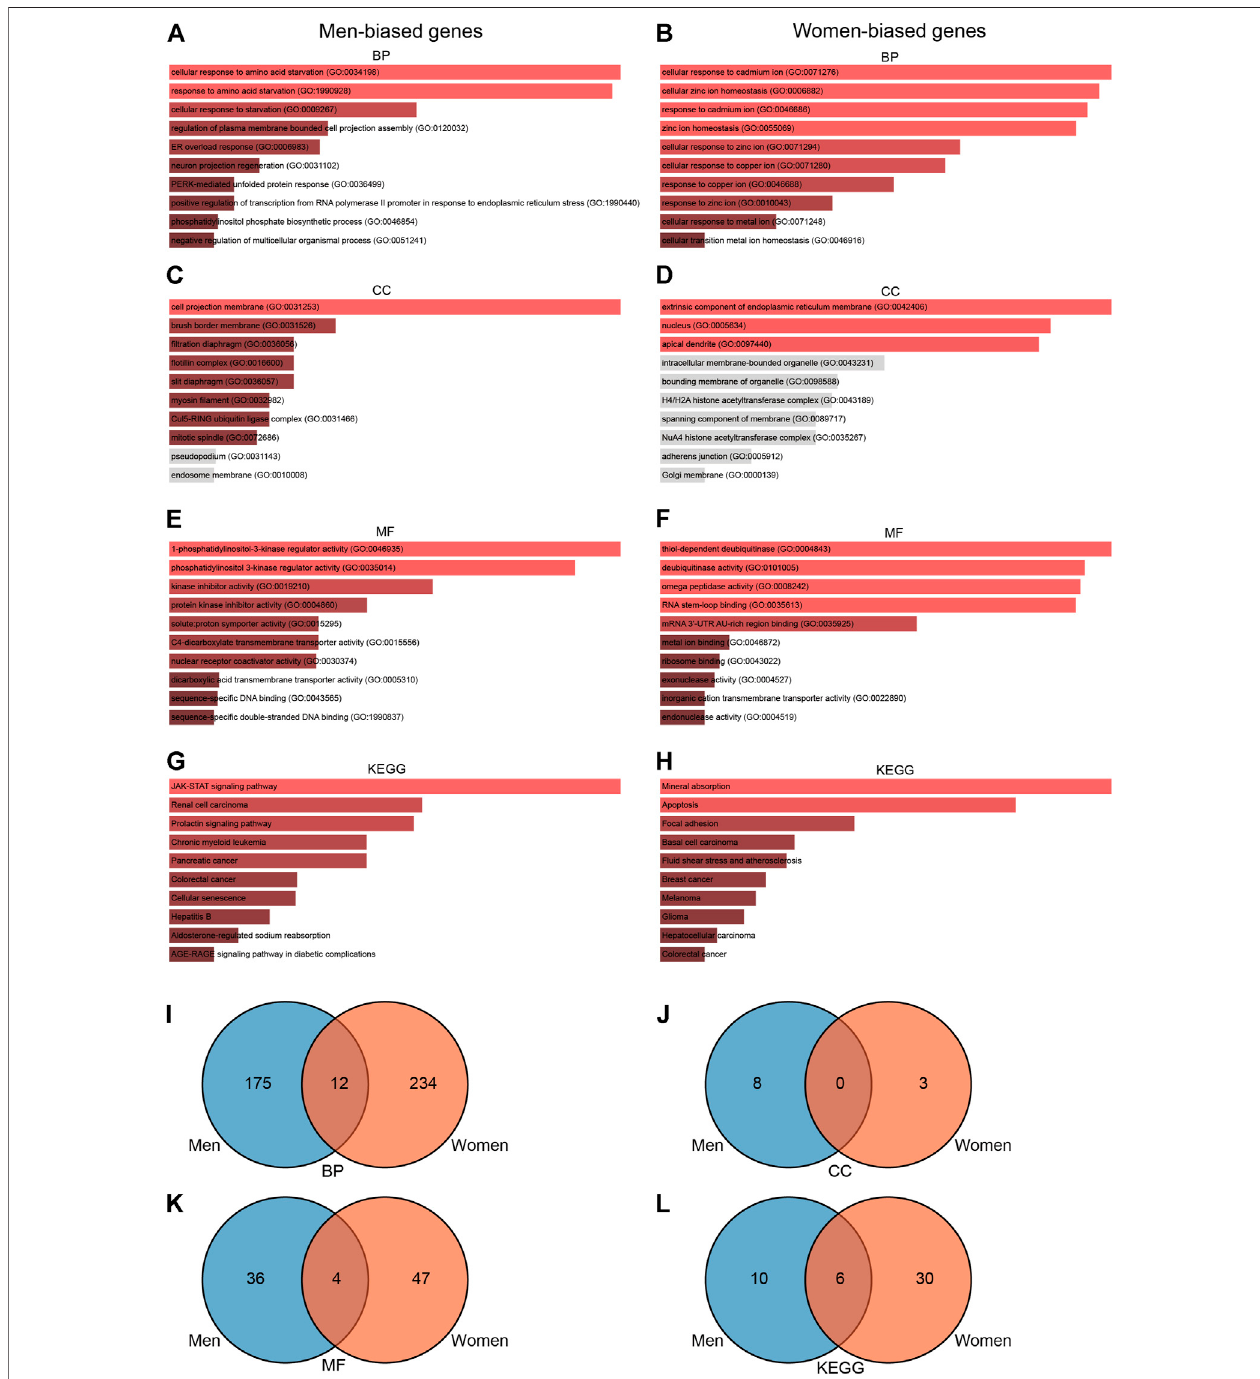
FIGURE 5 | GO and KEGG enrichment analyses of sexually dimorphic genes in men and women. (A) BP analyses of sexually dimorphic genes in men. (B) GO pathway analyses ofsexuallydimorphic genesin women. (C) CC pathway analyses of sexually dimorphic genes in men. (D) CC pathway analysesof sexually dimorphic genes in women. (E) MF enrichment analyses of sexually dimorphic genes in men. (F) MF enrichment analyses of sexually dimorphic genes in women. (G) KEGG enrichment analyses of sexually dimorphic genes in men. (H) KEGG enrichment analyses of sexually dimorphic genes in women. (I) Venn diagram showing the overlap of BP pathways between men-biased and women-biased genes. (J) Venn diagram showing the overlap of CC pathways between men-biased and women- biased genes. (K) Venn diagram showing the overlap of MF pathways between men-biased and women-biased genes. (L) Venn diagram showing the overlap of KEGG pathwaysbetween men-biased and women-biased genes. GO, Gene Ontology; BP, biological process; CC, cellular component; MF, molecular function; KEGG, Kyoto Encyclopedia of Genes and Genomes; TF, transcriptional factor.